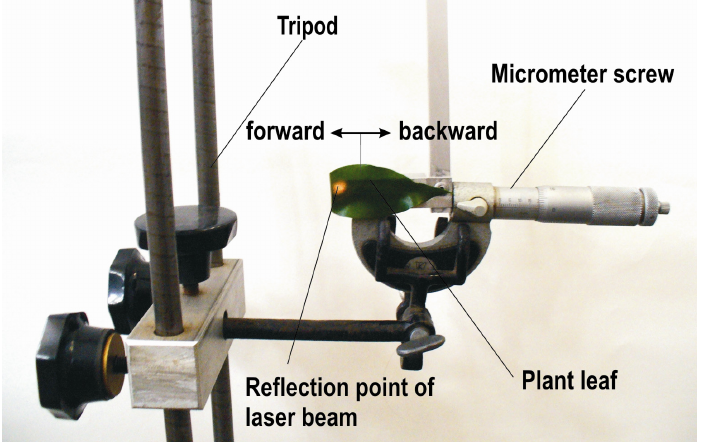
Figure 2. Investigation of sensor behaviour for two reflection levels (plant leaf and